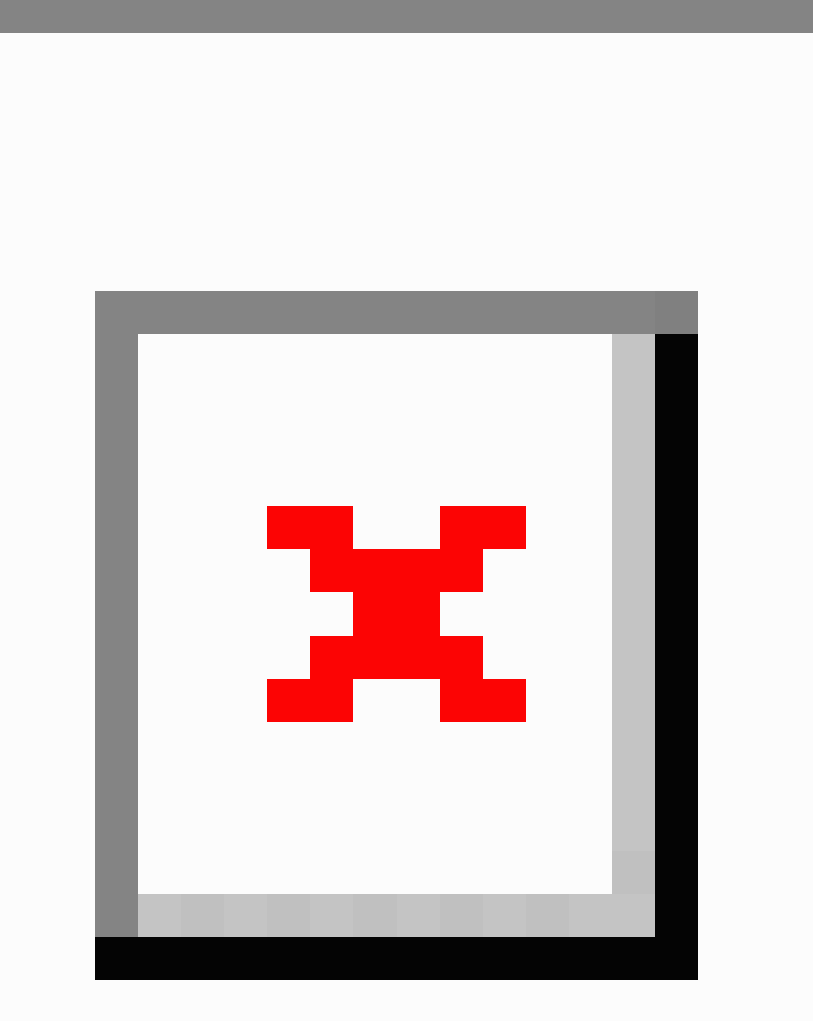
Figure 2. Tile-matching match-three game and step-by-step visual guide for solving each stage of a single 4-step round. In this version of the game, levels were carefully designed so that only one possible solution exists in each step